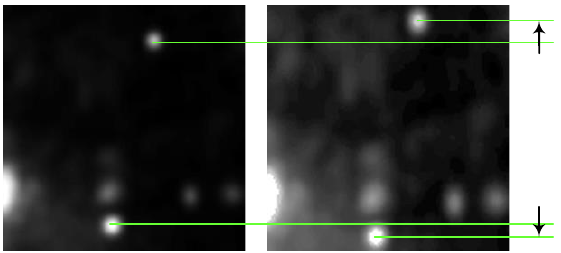
Figure 1. An example of an obvious non-translation relationship between patches. The left and right patches cannot be made to overlap each other, therefore, the relationship between the two patches cannot be described by offset.